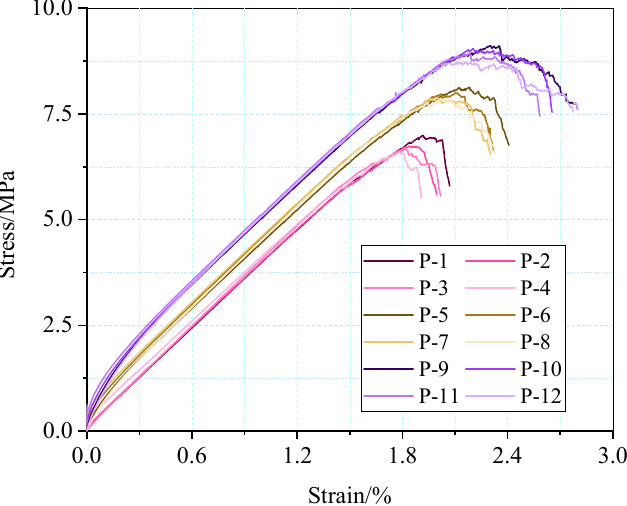
Figure 14. Stress–strain curves of different models.